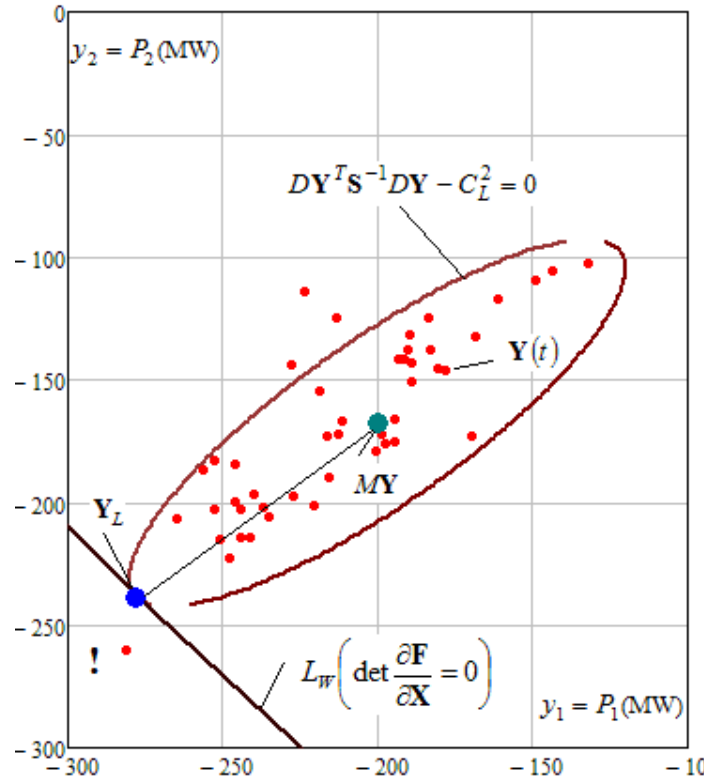
Figure 6. Increased risk of stability loss with an increase in the load oscillations amplitude ( R SAS = 17%).